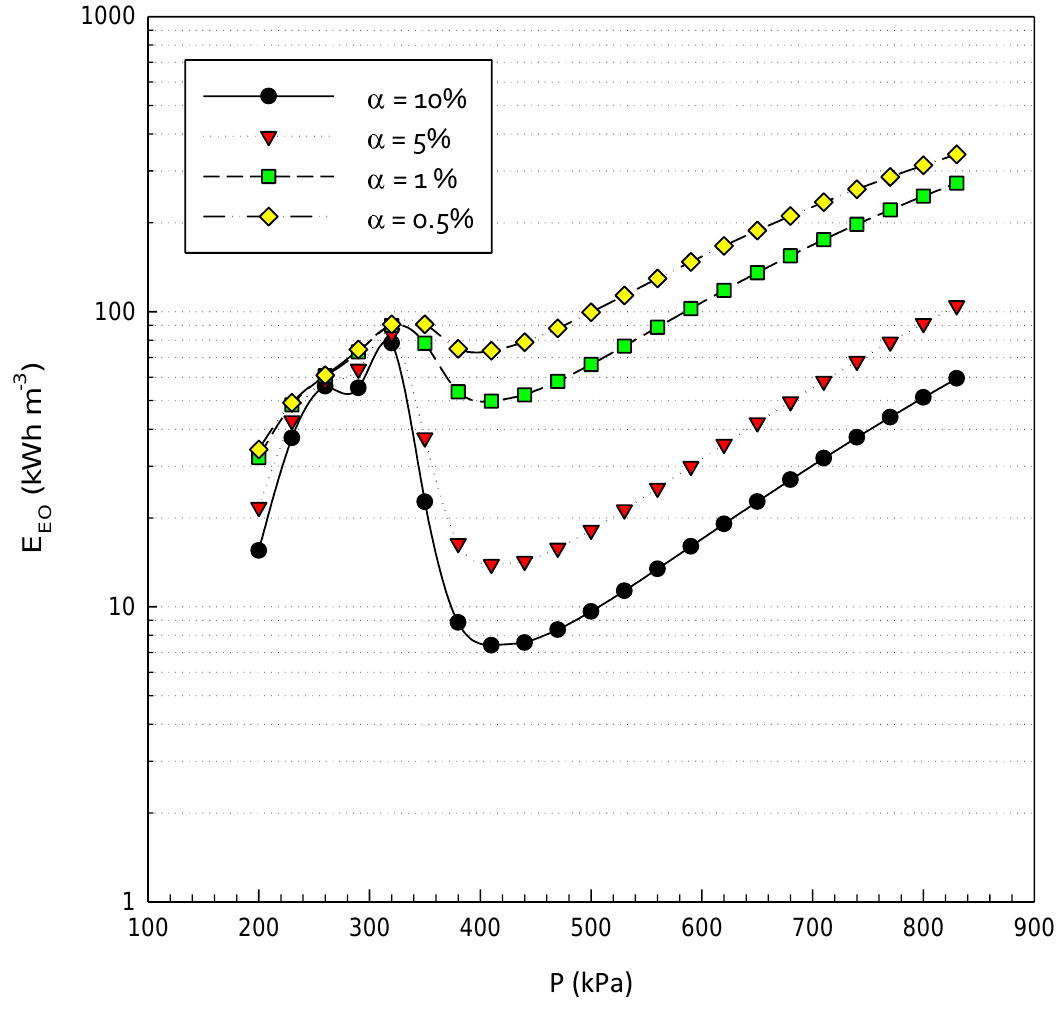
− 3 ) vs. Inlet Pressure